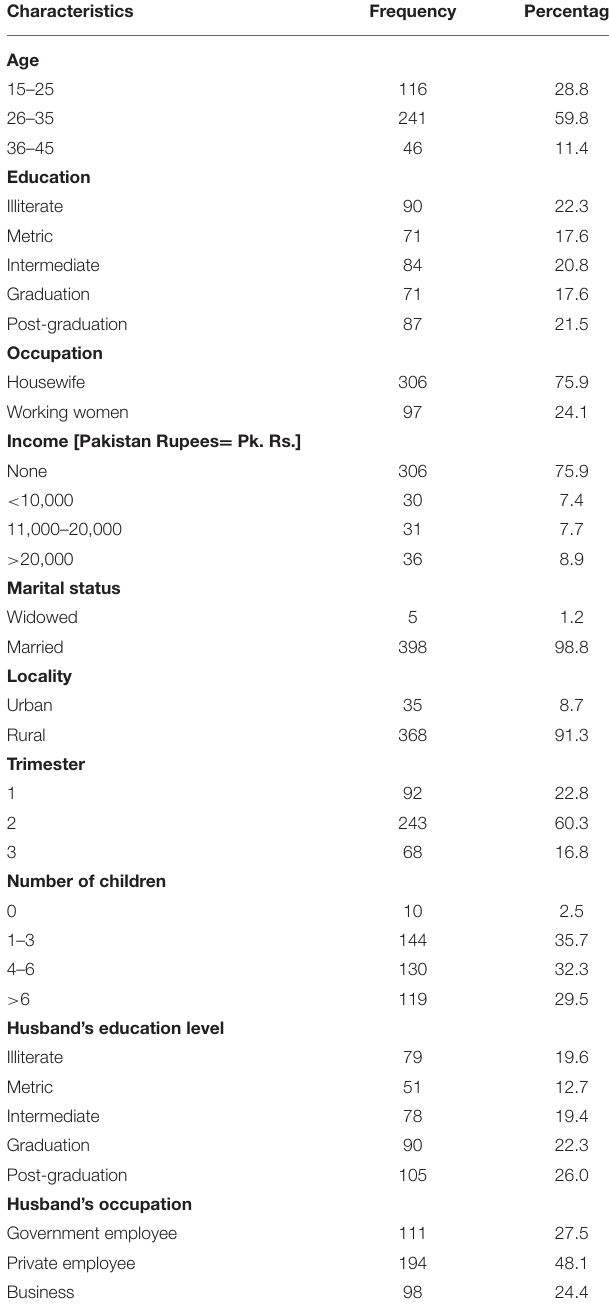
TABLE 1 | Demographic characteristics of study